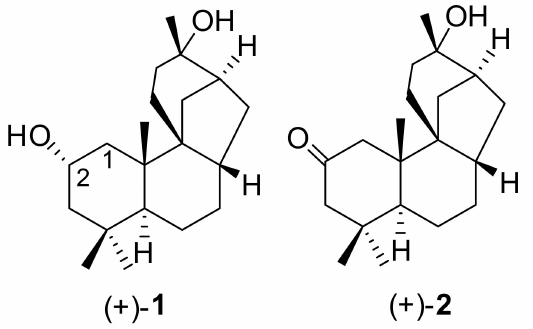
Figure 2. (+)-Stemodin ( 1 ) and (+)-stemodinone ( 2 ).